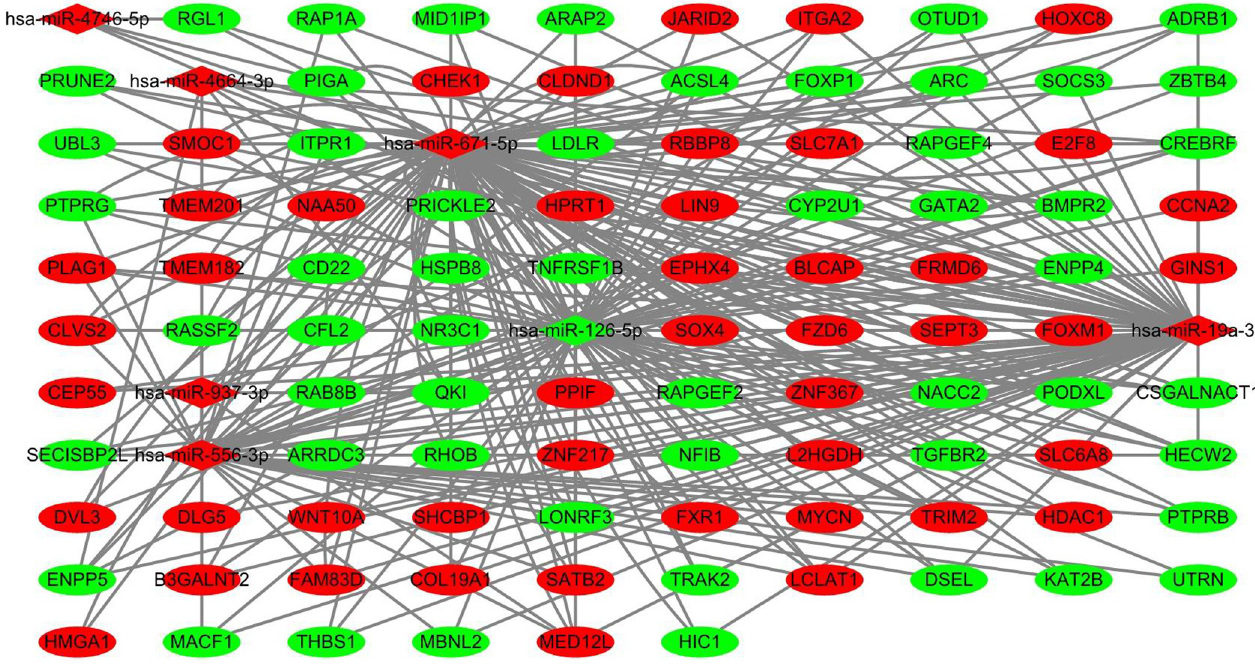
Fig 7. Potential association between microRNA and target genes. Red dot indicates upregulated, and green dot means downregulated.